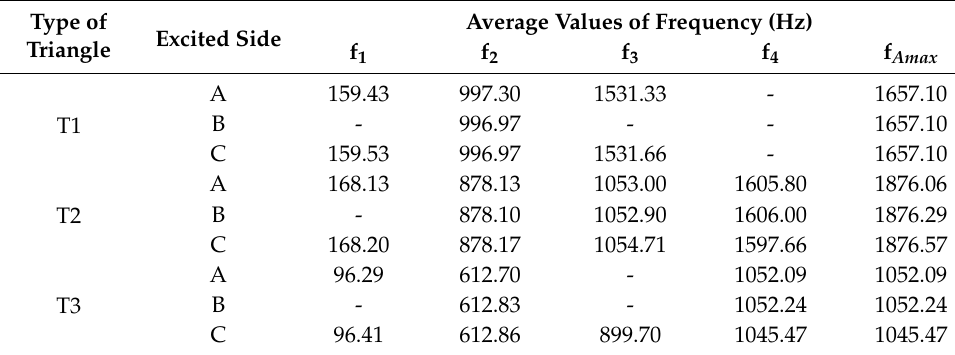
Table 3. The first natural frequencies obtained experimentally. Type of Excited Triangle